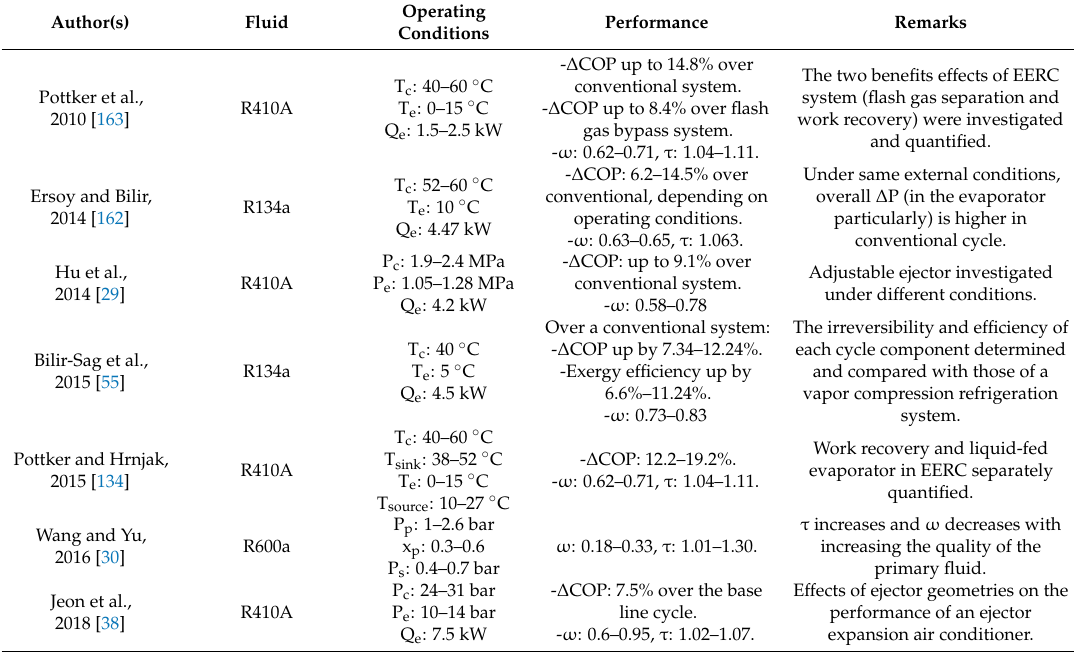
Table 6. Selection of EERC relevant experimental studies (synthetic refrigerants).